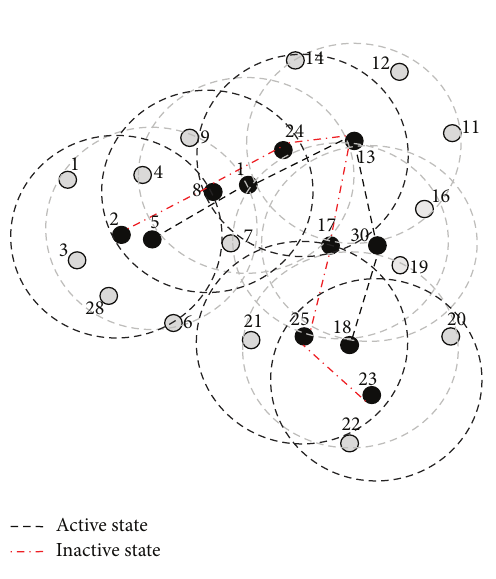
Figure 5: CDS with activity scheduling.